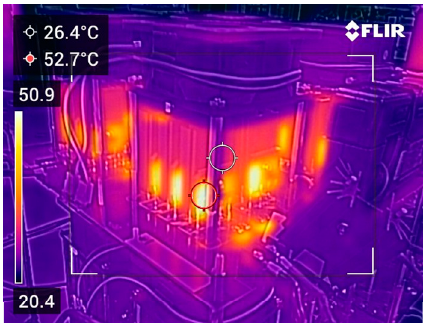
Figure 23. Temperature saturation during the PVE thermal test.